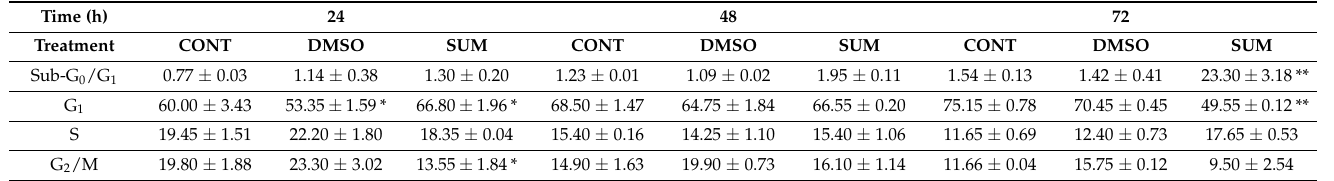
Table 3. The cell cycle distribution in MCF-7 cells after sumac treatment.